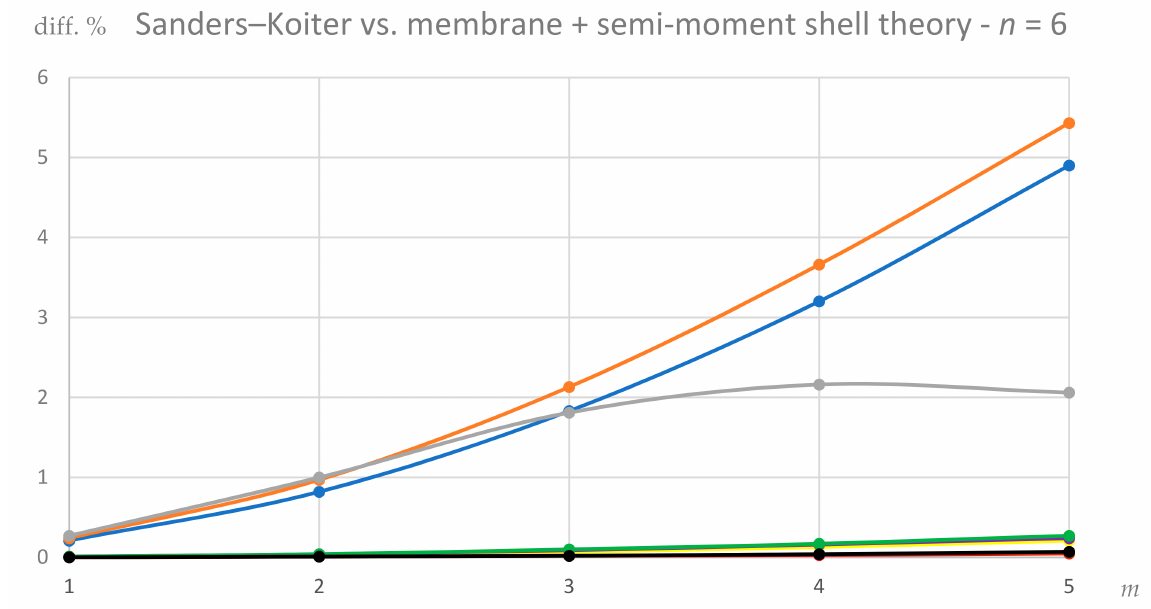
Figure 16. Simply supported DWCNT of Table 1 with different values of aspect ratio L / R 2 and thickness ratio R 2 / h . Shell-like modes ( n = 6). Comparisons between extended Sanders–Koiter and membrane + semi-moment shell theory, where L / R 2 = 10, R 2 / h =